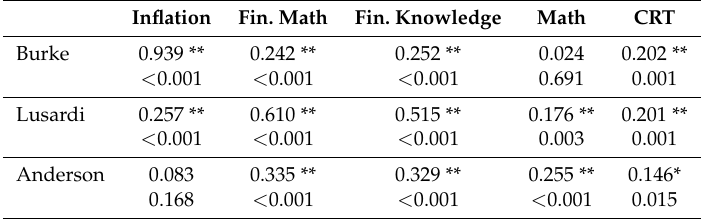
Table 6. Correlations of the financial literature measures with question categories. Inflation Fin. Math Fin. Knowledge Math